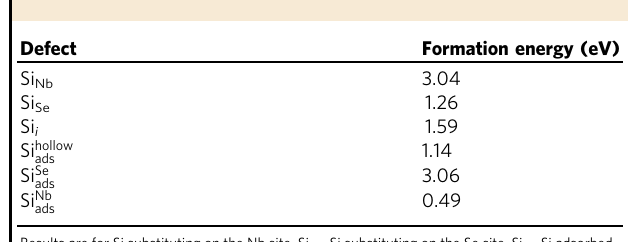
Table 2 Formation energy of Si in NbSe 2 under Nb-rich conditions.